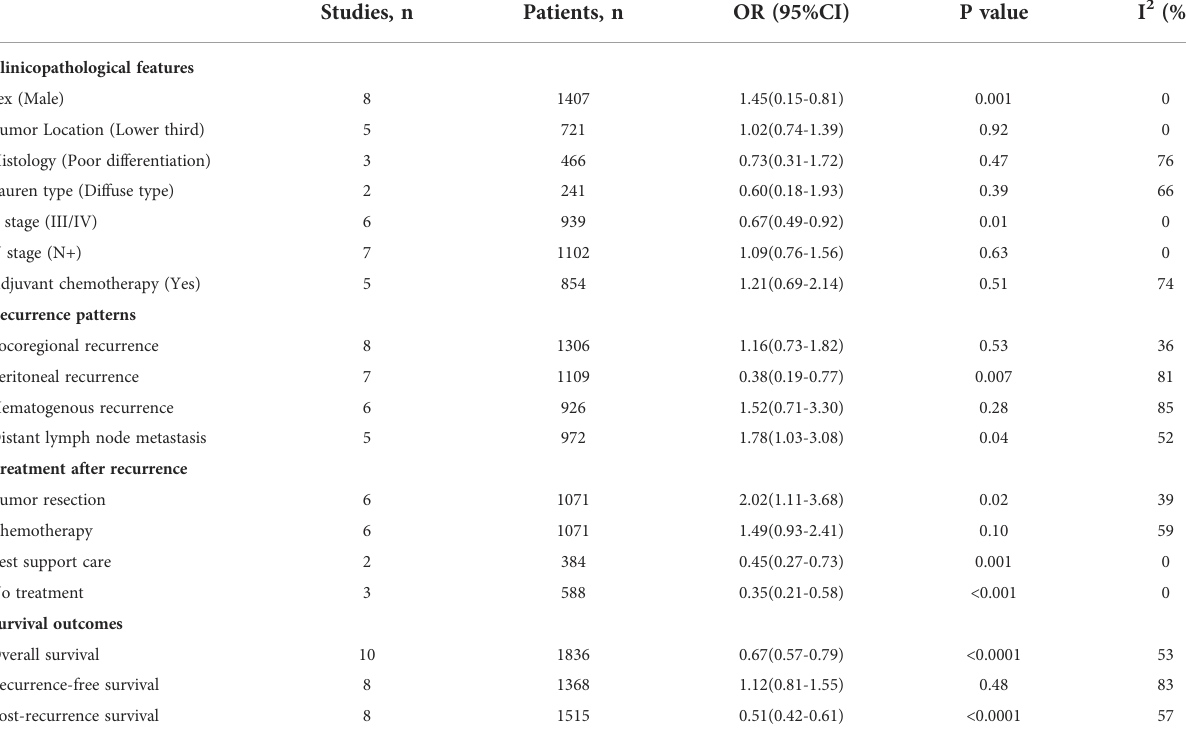
TABLE 2 Baseline features and outcomes of AR patients vs. SR